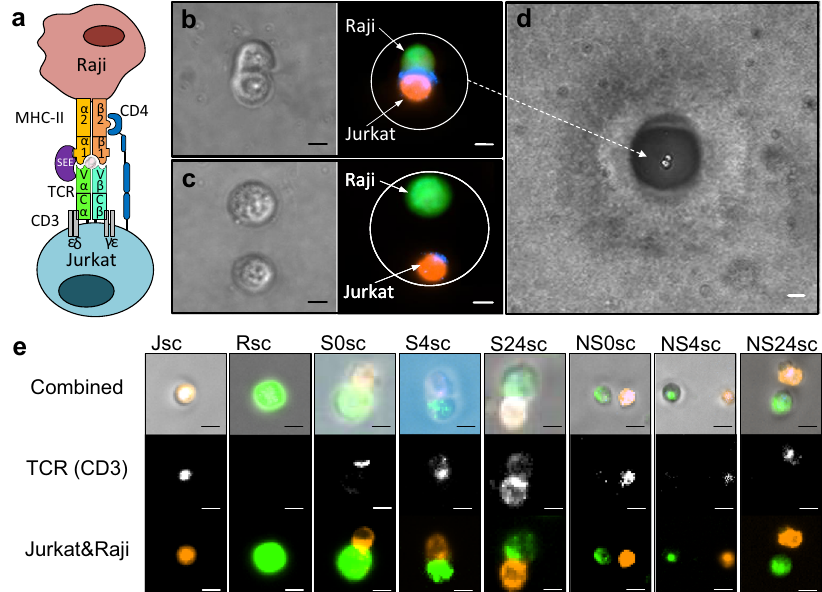
Fig. 3 Using See-N-Seq to isolate complex cell phenotypes for RNA sequencing. a Schematic of an immunological synapse formed between Jurkat and Raji cell using Staphylococcus aureus enterotoxin E (SEE) superantigen. b Micrographs of an immunological synapse formed between Jurkat cell (orange) and SEE treated-Raji cells (green). TCR is identi fi ed using anti-CD3 (blue) localized at the interface of the two cells. Scale bar = 5 µ m. c Micrographs of a non-synapsing Jurkat-Raji cell pair. Scale bar = 5 µ m. d Jurkat-Raji cell pair in B isolated via See-N-Seq. Scale bar = 25 µ m. e Micrographs of sequenced cells or cell pairs including single Jurkat (Jsc) and Raji (Rsc) cells; synapsing cells at 0, 4 and 24 h (S0sc, S4sc, S24sc); as well as non-synapsing cells at 0, 4 and 24 h (NS0sc, NS4sc, NS24sc). Scale bar = 5 µ